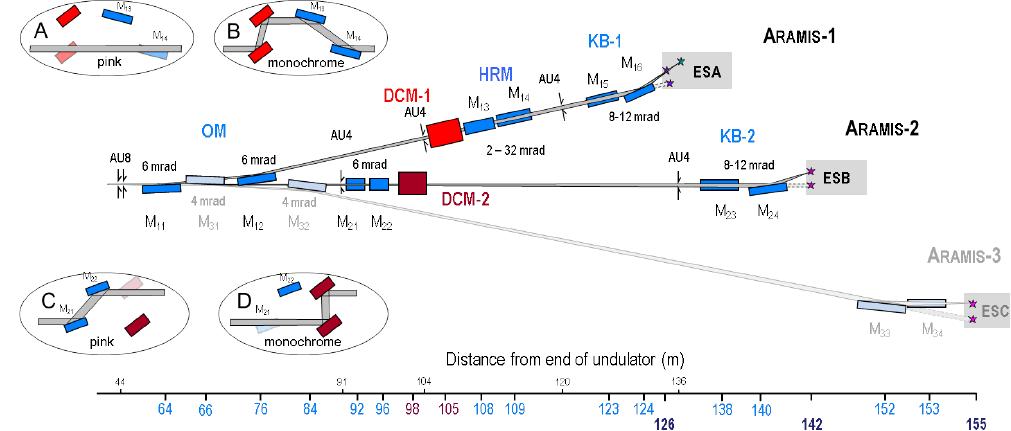
Figure 6. Optical layout of the hard X-ray beamlines of the Aramis undulator. The insets show the setup for pink and monochromatic operation of the beamlines Aramis-1 (A,B) and Aramis-2 (C,D),